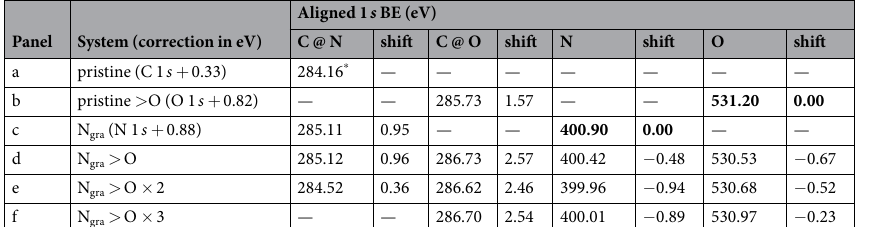
Aligned 1 s BE (eV) C @ N shift C @ O shift N shift